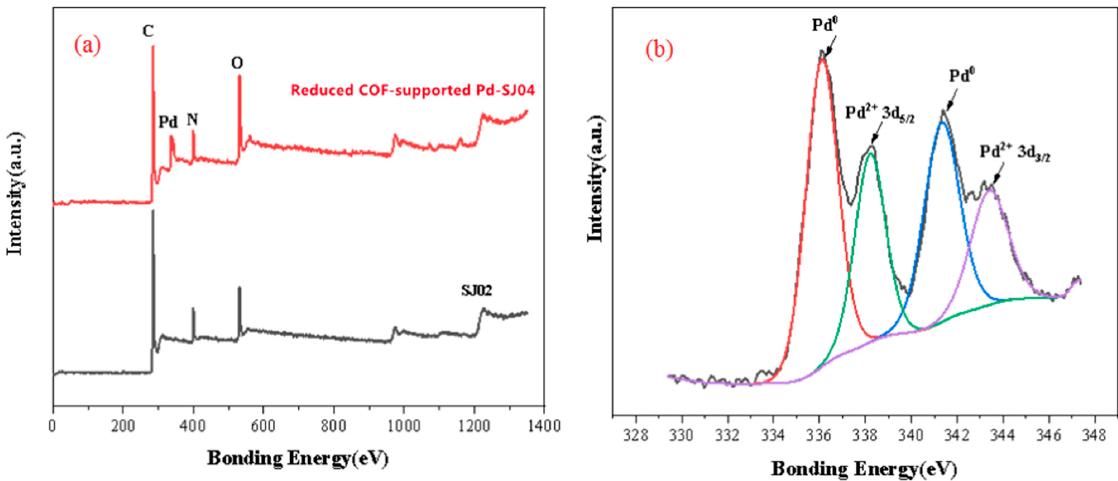
Figure 4. ( a )The survey and ( b ) Pd3d high-resolution XPS spectra corresponding to reduced COF-supported Pd-SJ04 . The survey spectrum of SJ02 is also included as a reference sample.